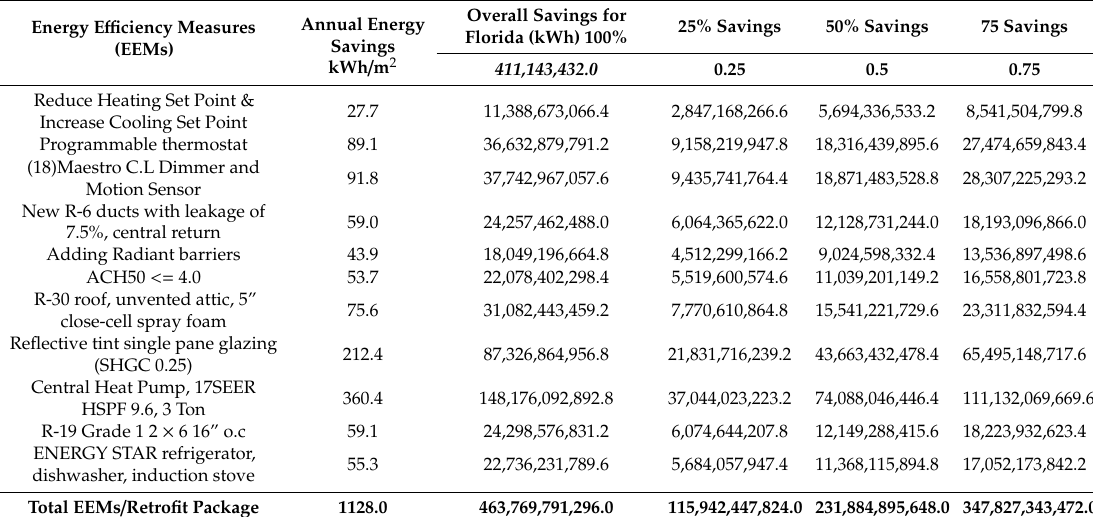
Table 10. Energy Use Intensity (EUI) for the implement Energy E ffi ciency. Measures (EEMs) / Retrofit Improvement